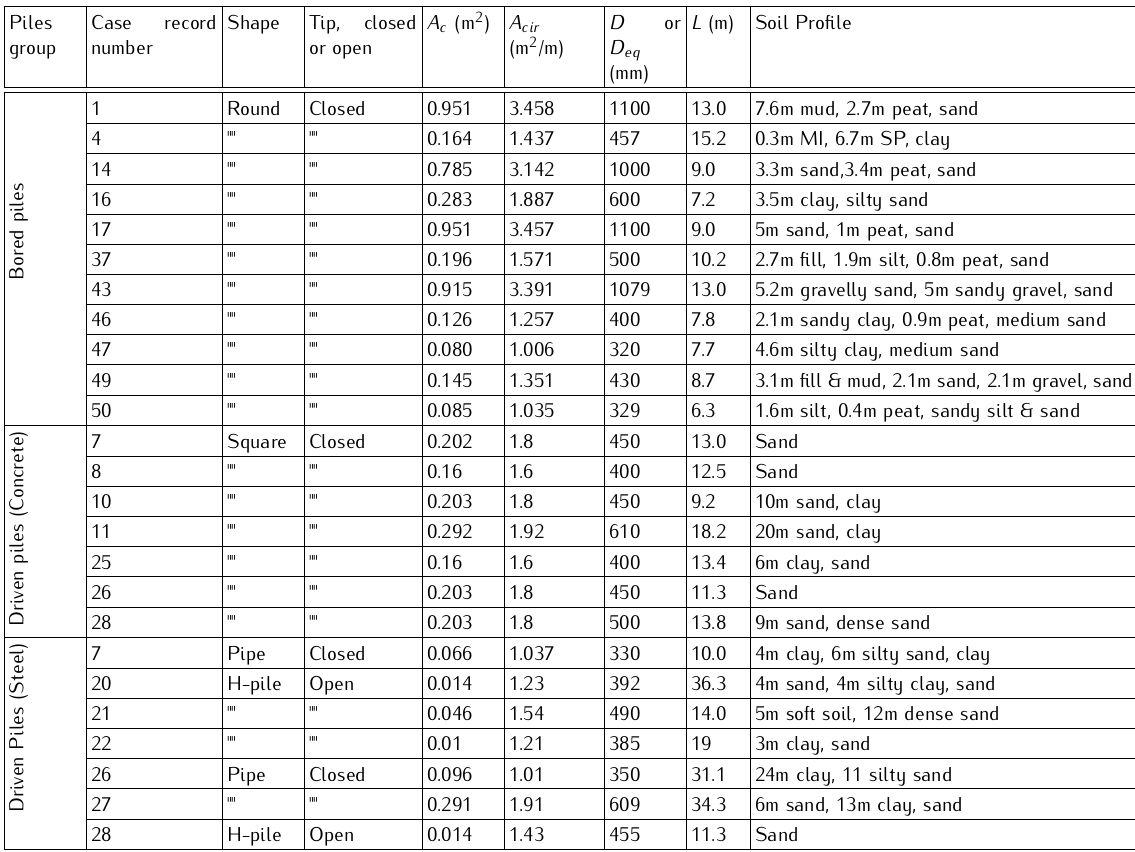
Table 3. Summary of the case records shown in the Figures 5-10.